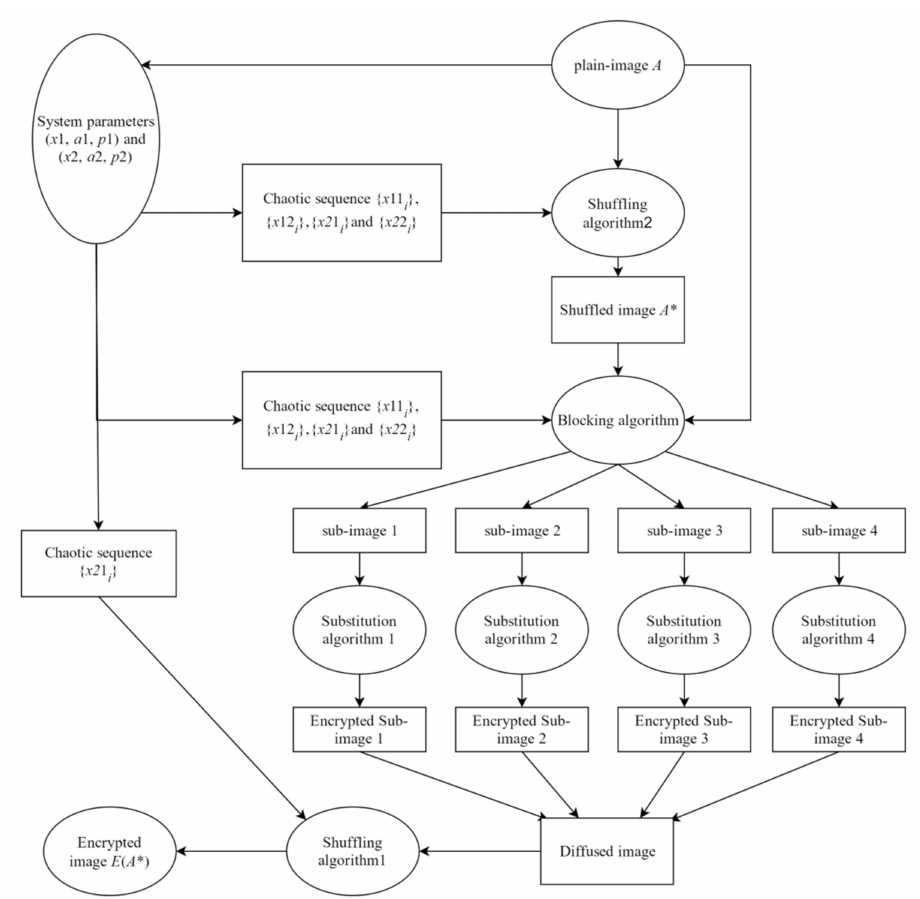
Figure 9. The flowchart of the